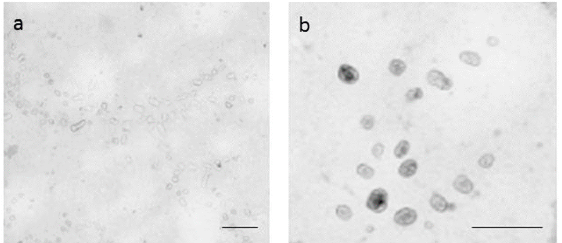
Figure 8. Electron microscopy evaluation of exosomes isolated from T98G cells at different magnification ( a , b ). Exosomes were isolated from exosome depleted FBS-containing medium of T98G growing cells at about 80% of confluence from a 90-mm cell plate and visualized by transmission electron microscopy. The bar size is 200 nm.